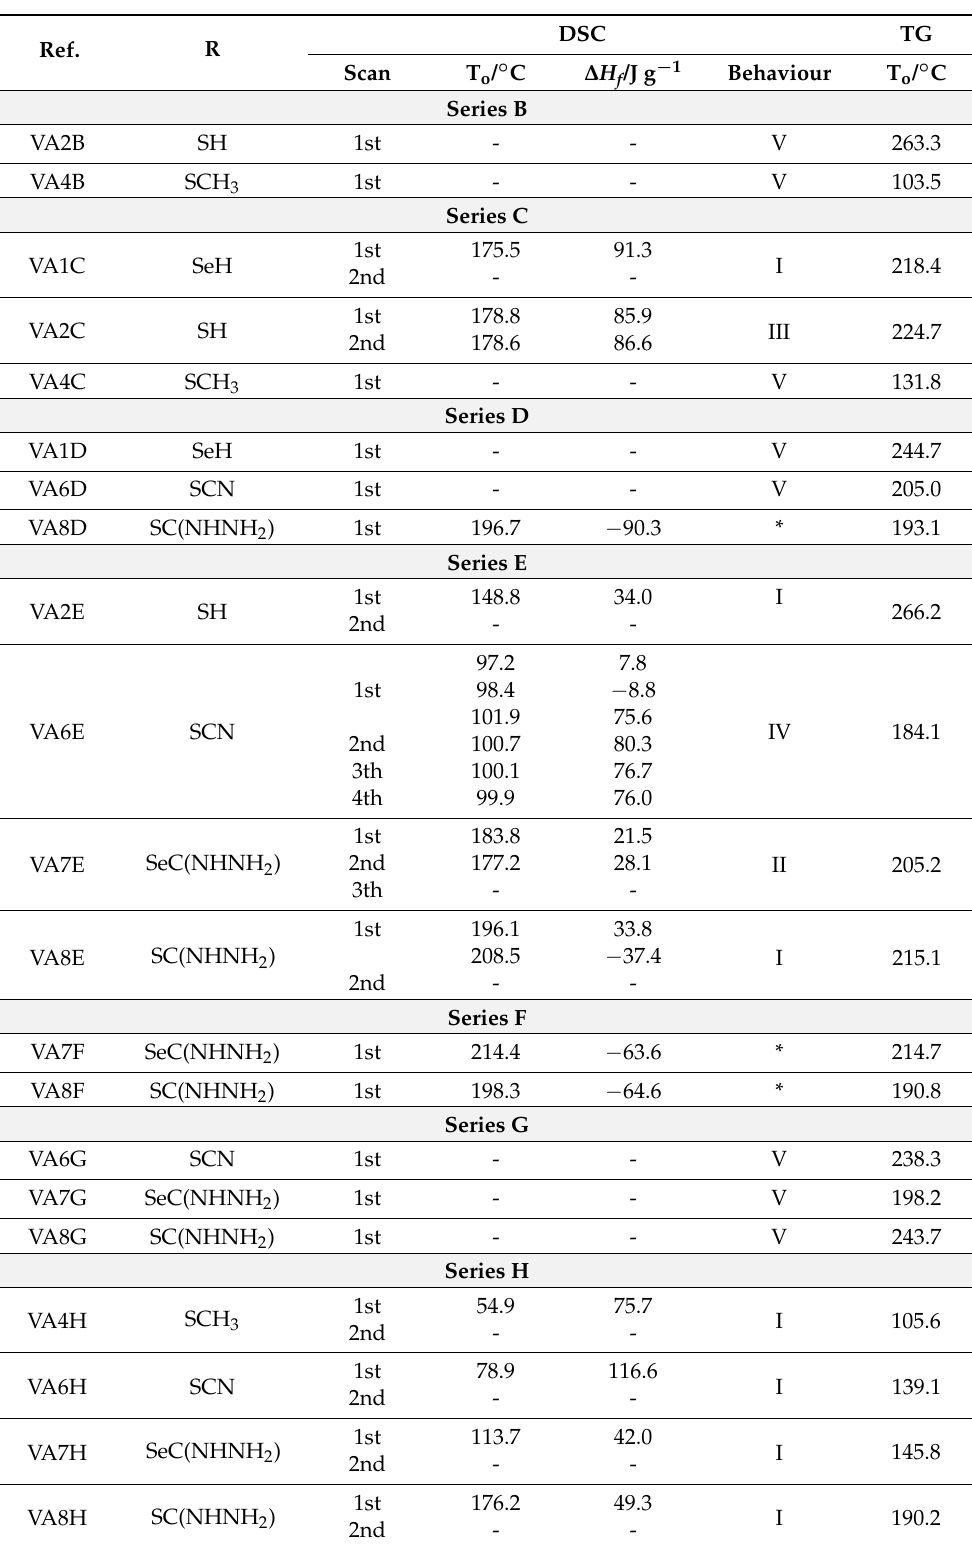
Table 5. Thermal data obtained by DSC and